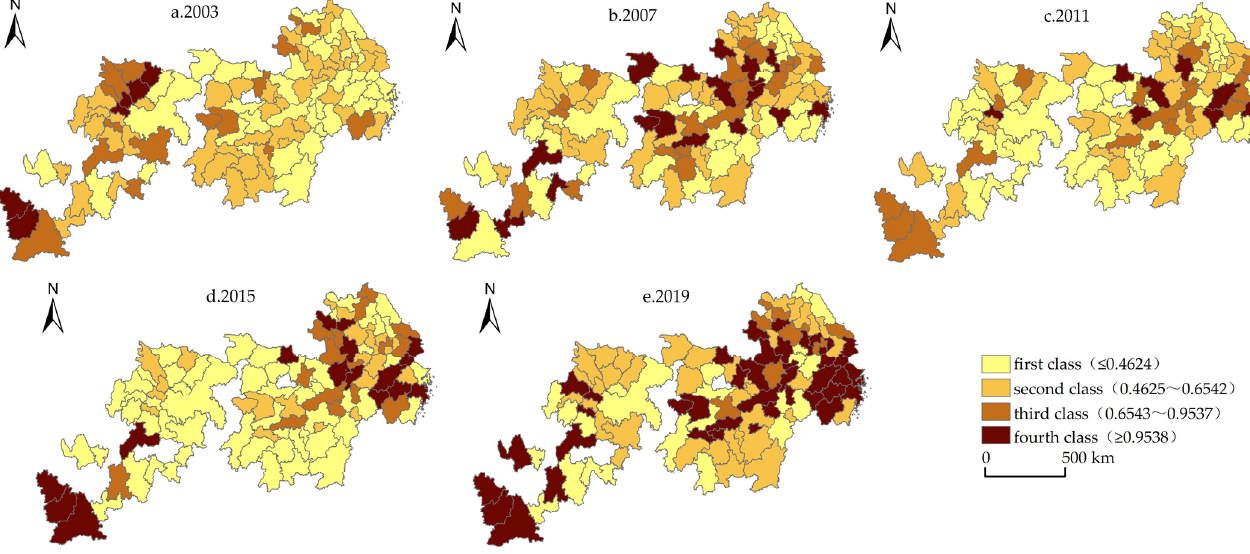
Figure 4. The spatial distribution of ULUE in the Yangtze River Economic Zone. ( a ) ULUE in 2003; ( b ) ULUE in 2007; ( c ) ULUE in 2011; ( d ) ULUE in 2015; ( e ) ULUE in 2019.